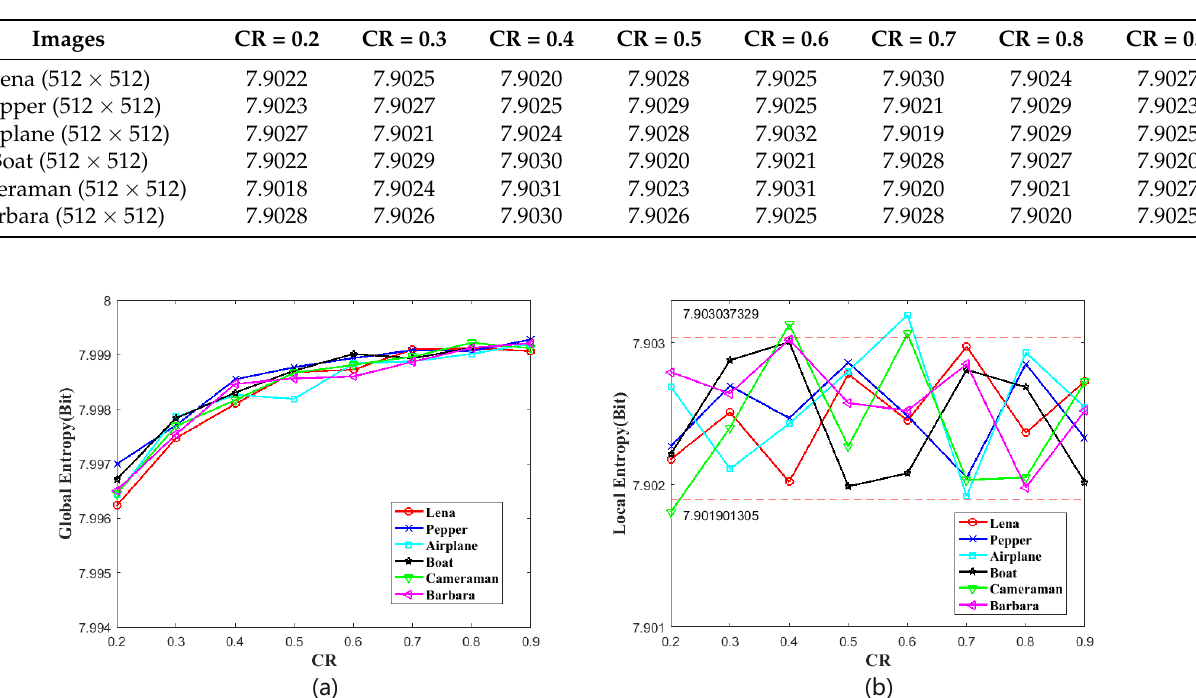
Table 8. The local Shannon entropy test.